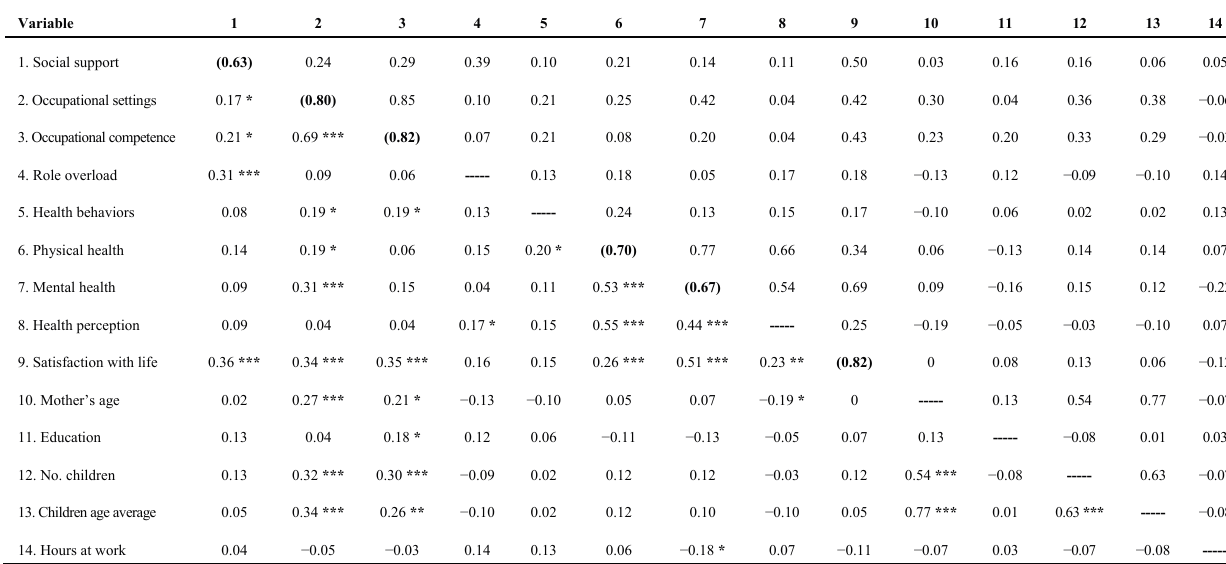
Table 3. Pearson correlations (simple correlations below and correction for attenuation above the main diagonal line) between all study variables (N =